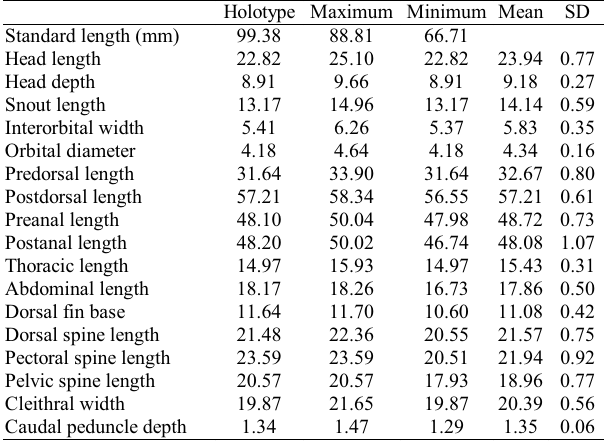
Table 2 . Morphometric data of Harttia merevari expressed as percent of SL